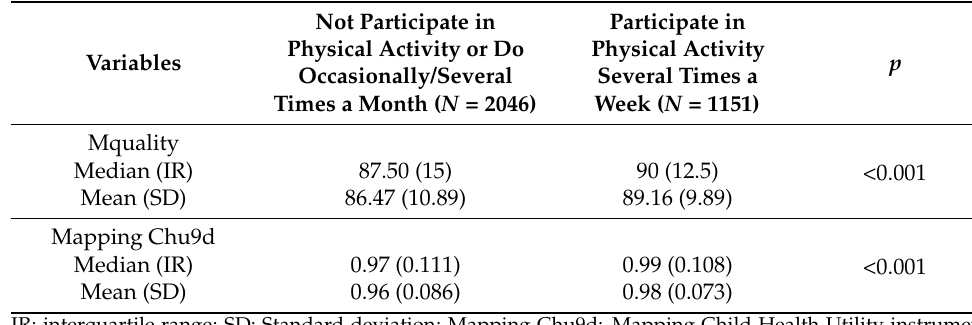
Table 3. Analysis of HRQoL values for the Mquality and Mapping Chu9d variables by